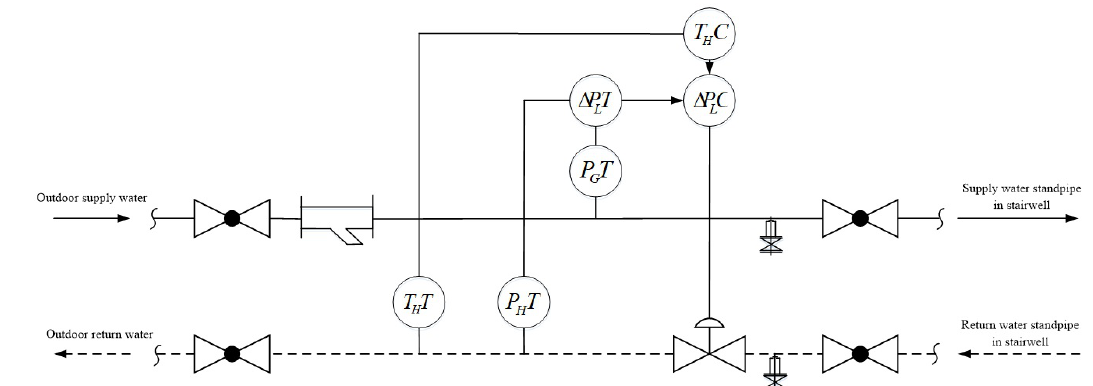
Fig. 3 Unit branch cascade control